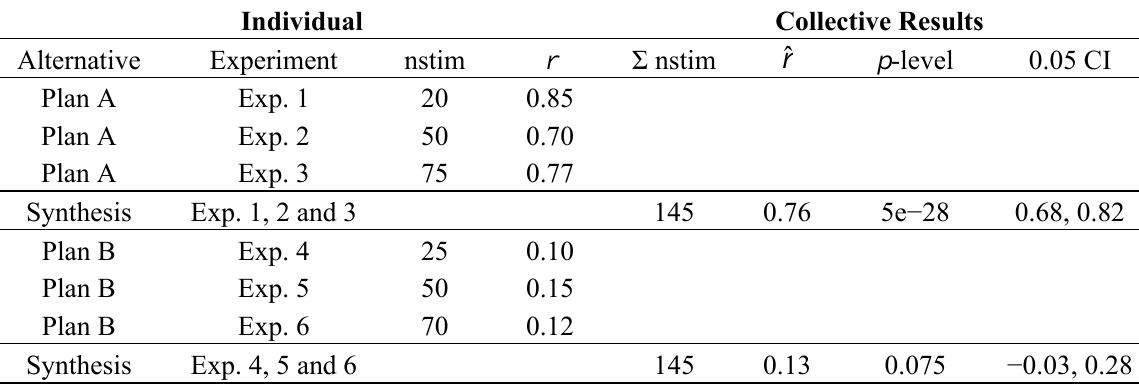
Table 1. Hypothetical efficacies (measured as r ) of Plans A and B.